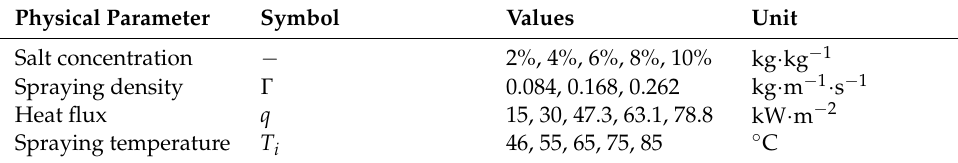
Table 3. The parameter settings under various conditions.